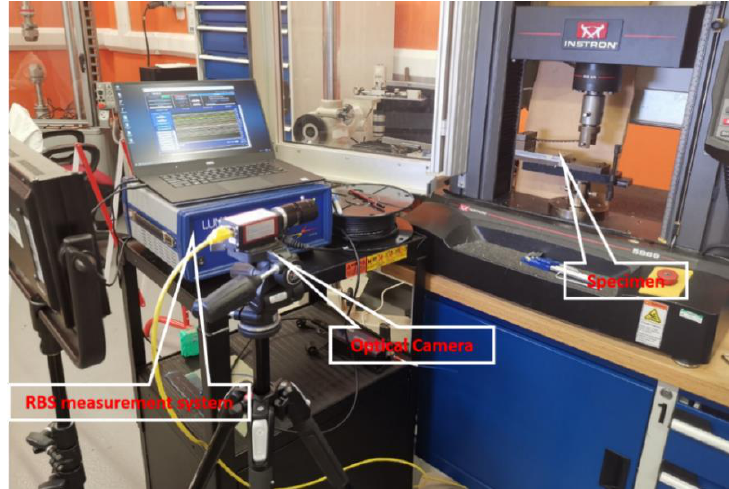
Figure 20. Experimental setup.